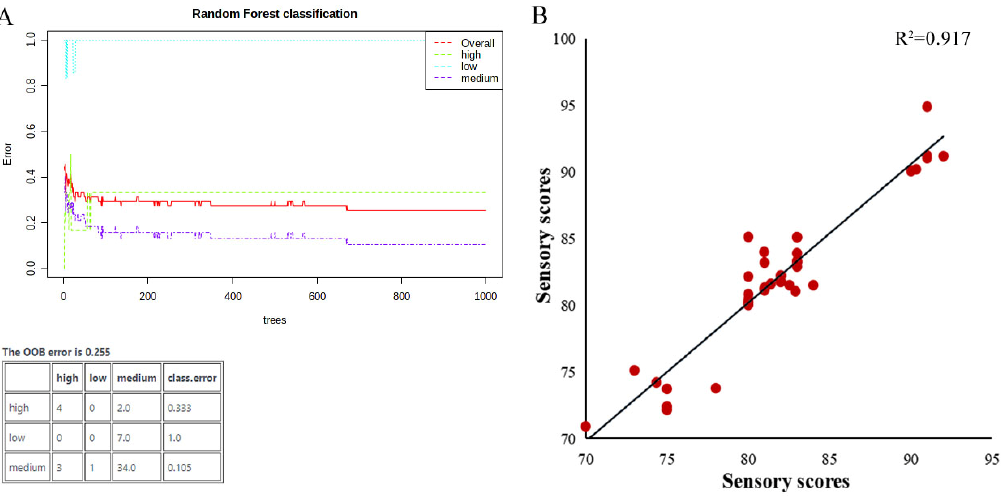
Figure 3. Grade ‐ predicted model validation of rice. ( A ) RF results with lipids biomarkers. ( B ) Correlation study of sensory scores between actual and predicted ones by potential lipid biomarkers.